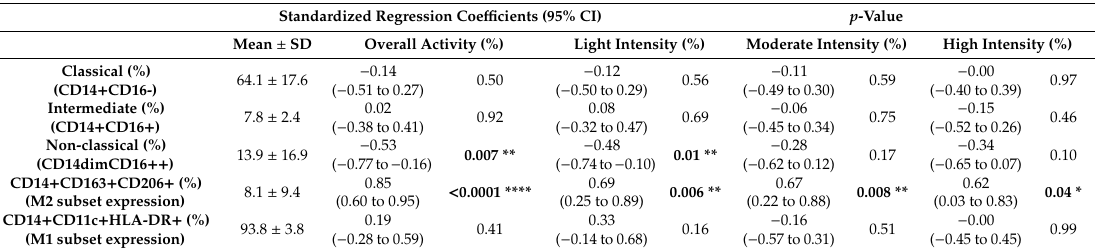
Table 3. Regression analysis of the percentage of time spent at di ff erent intensity levels of PA, metabolic risk variables, and monocytic cell surface markers Standardized Regression Coe ffi cients (95% CI) p -Value Mean ± SD Overall Activity (%) Light Intensity (%)